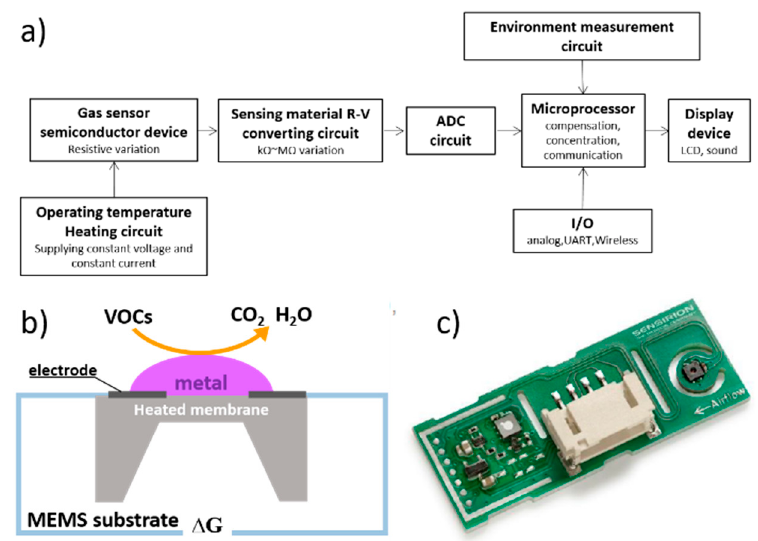
Figure 1. ICT-TVOC sensor: ( a ) semiconductor gas sensor device; ( b ) the principal of the semiconductor sensor; ( c ) SVM 30 (Sensirion). ICT, information and communications technology; TVOC, total volatile organic compounds.